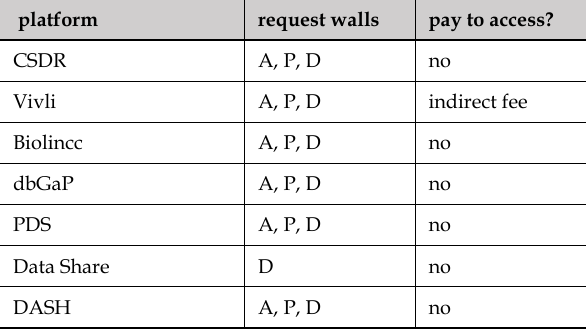
Table 2 Platform Access Requirements*